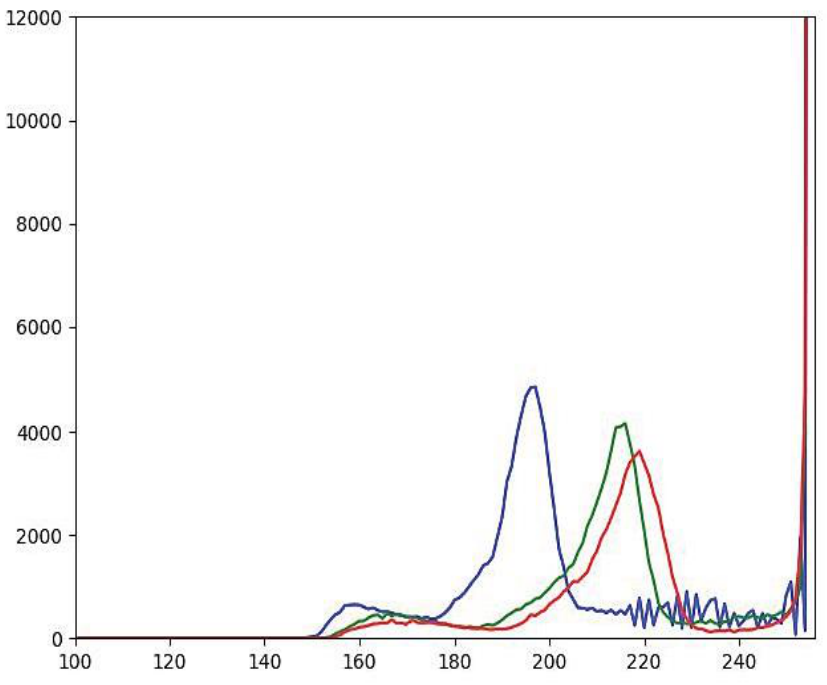
Figure 37. Histogram of the RGB graph for the image (see Figure